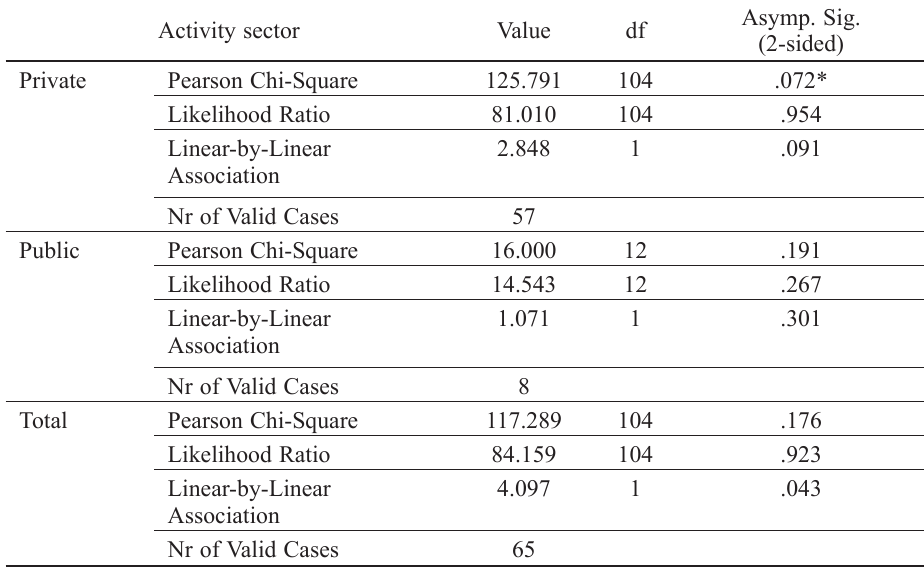
Table 8. Modules implemented / Time spent by private and public